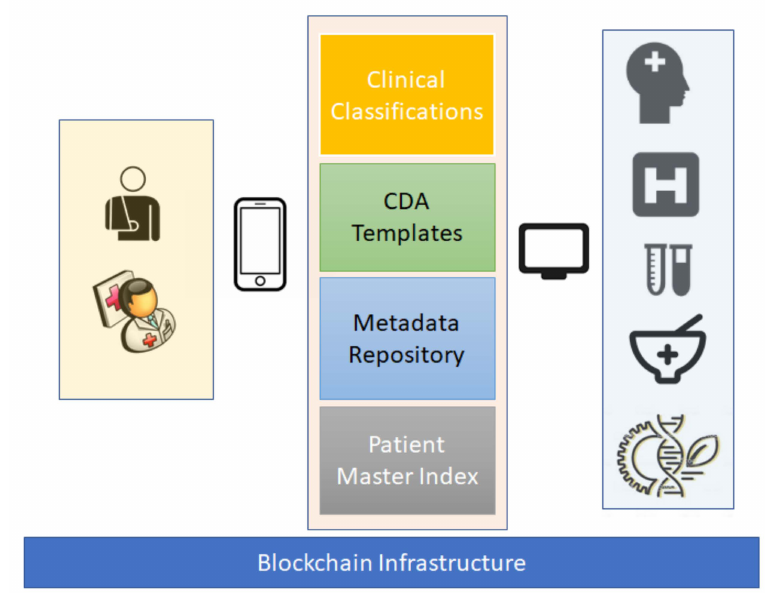
Figure 3. Proposed